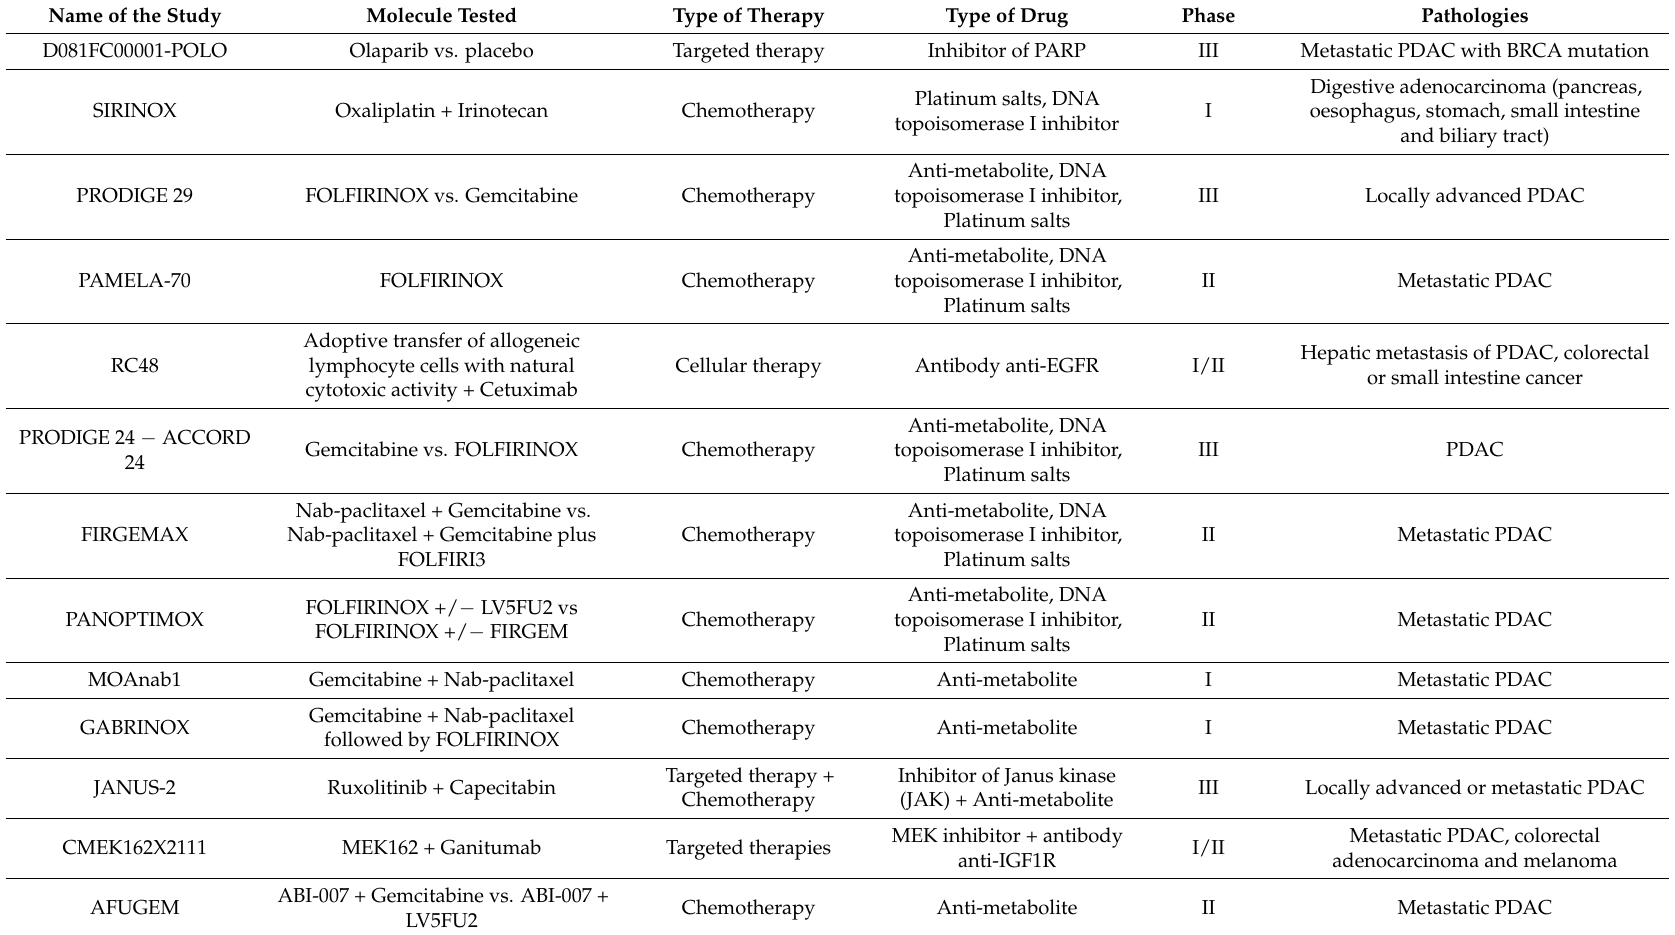
Table 3. Ongoing clinical trials for pancreatic cancer in France . In grey: clinical trials combining a targeted therapy with a chemotherapy. In blue: clinical trials using a targeted therapy only. Adapted from clinical.gouv.fr, updated in August